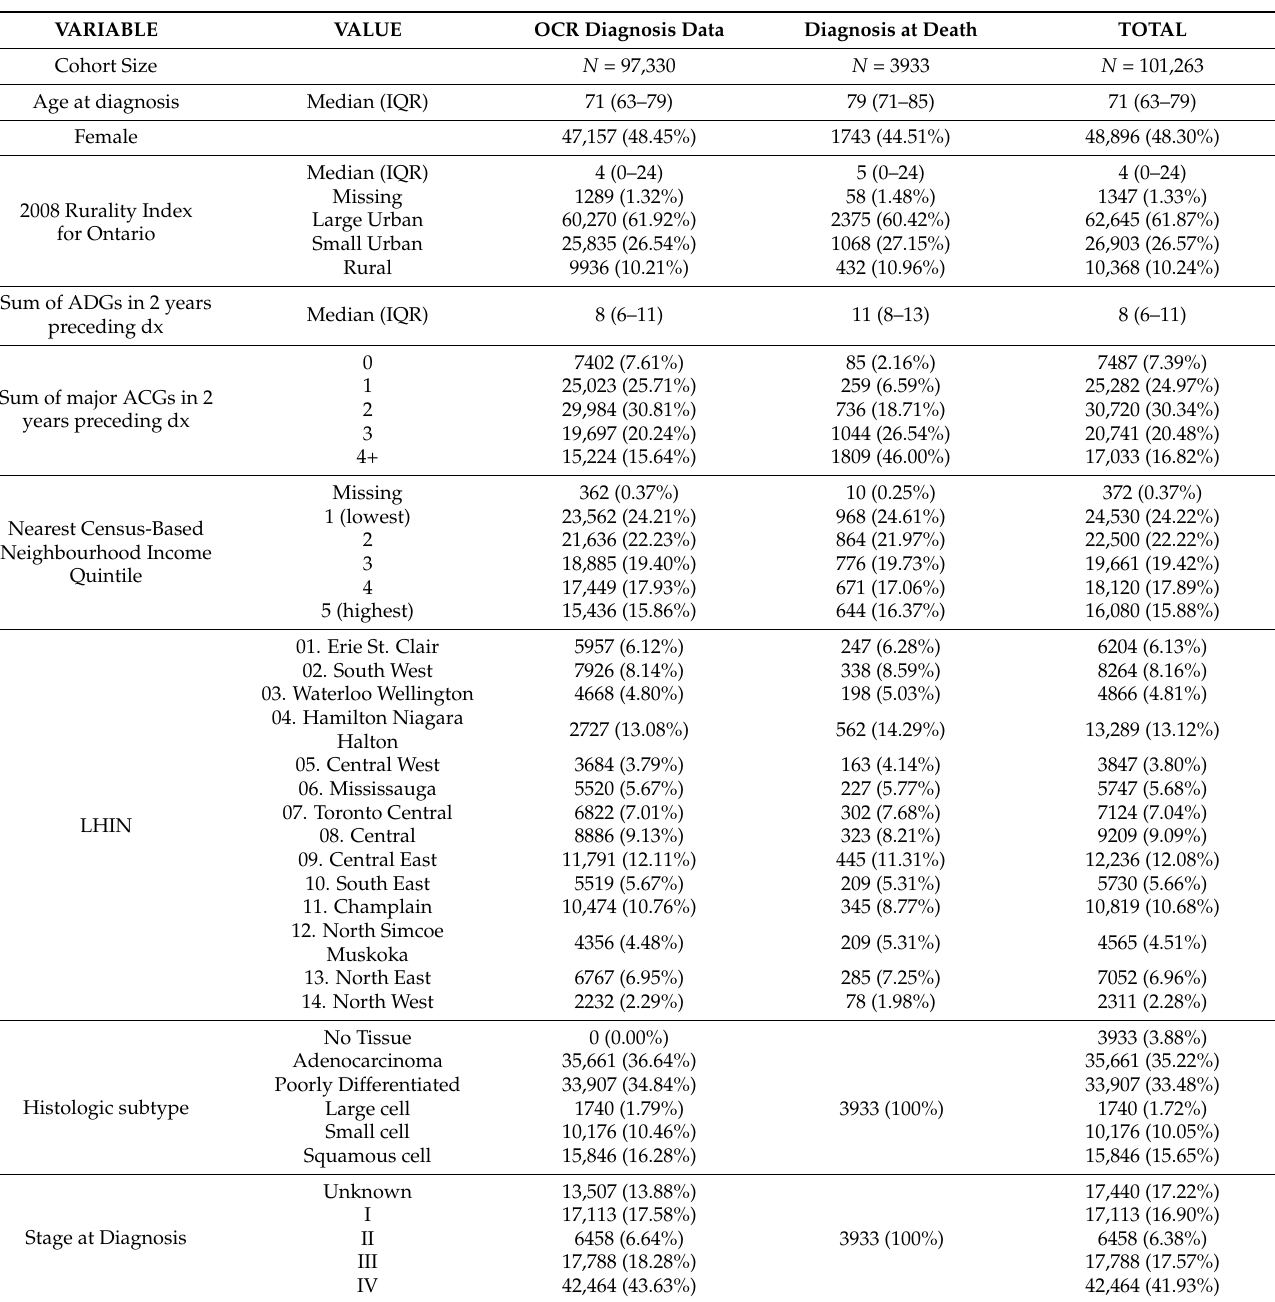
Table 2. Patient characteristics for entire lung cancer